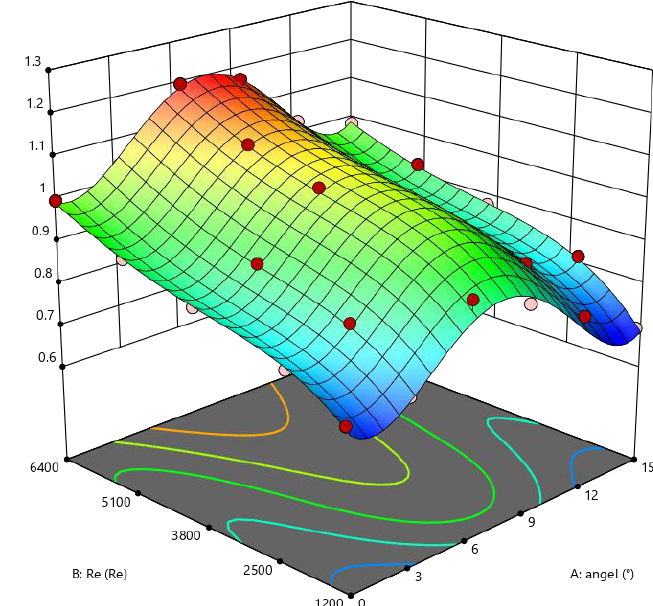
Figure 16. Relationship between design variables and target